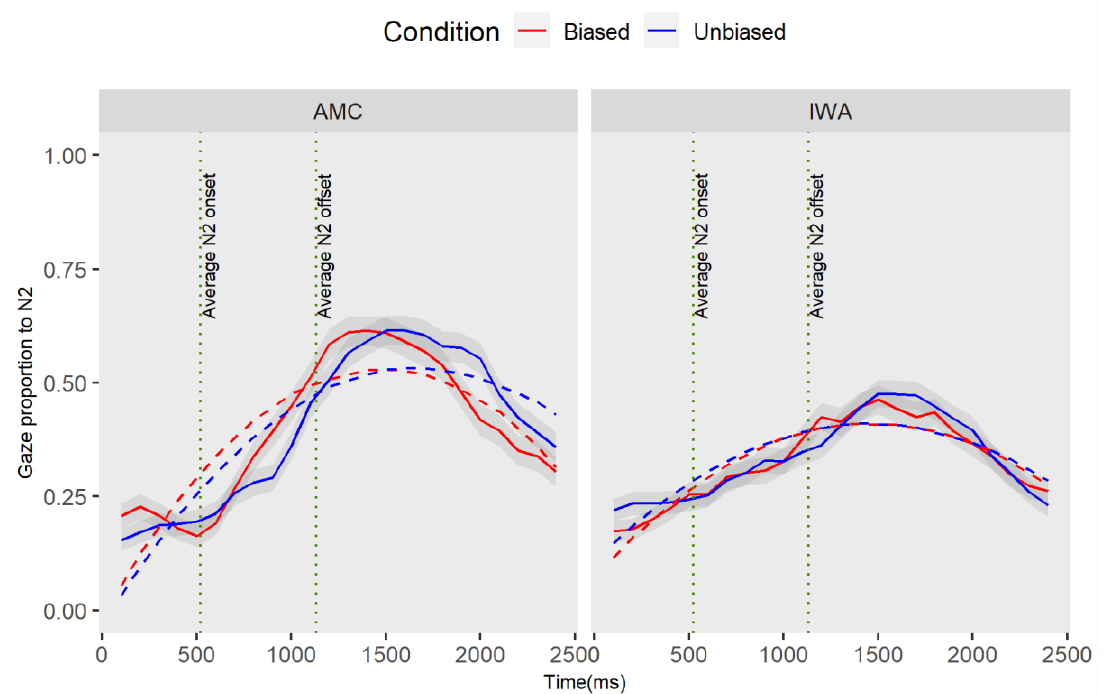
Figure 6. The plot captures the following part of the sentence “/adjective/snake that the bear”. This plot demonstrates the gaze proportion differences to N2 between conditions and groups. Solid lines represent observed data and dashed lines represent the GCA model fit. The graphic representation of the model is showing the quadratic fit, yet the marginal results for the group effect were observed at the intercept level, in addition to the interaction effect which was significant at the linear term.